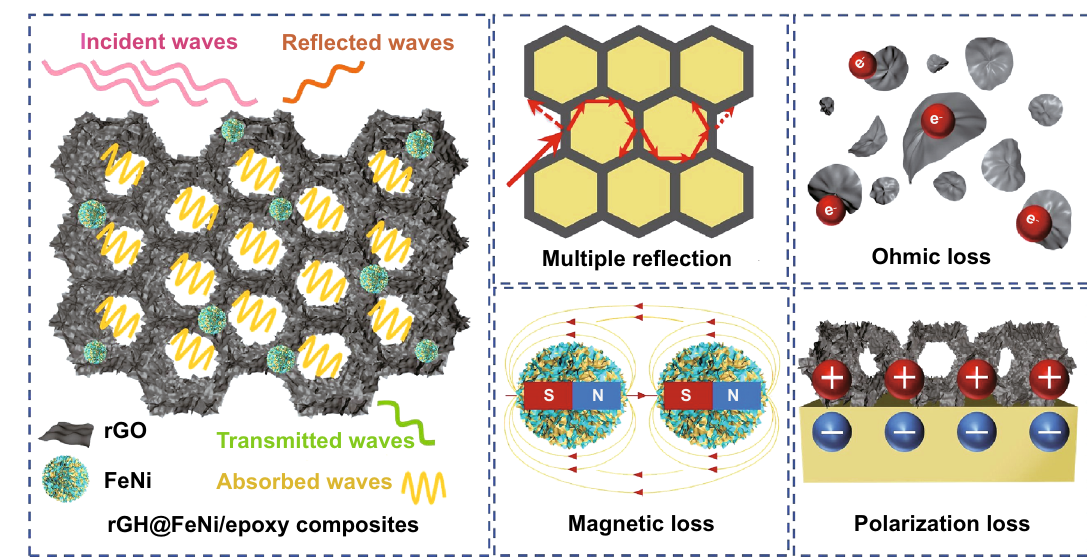
Fig. 5 EMI shielding mechanism of rGH@FeNi/epoxy composites